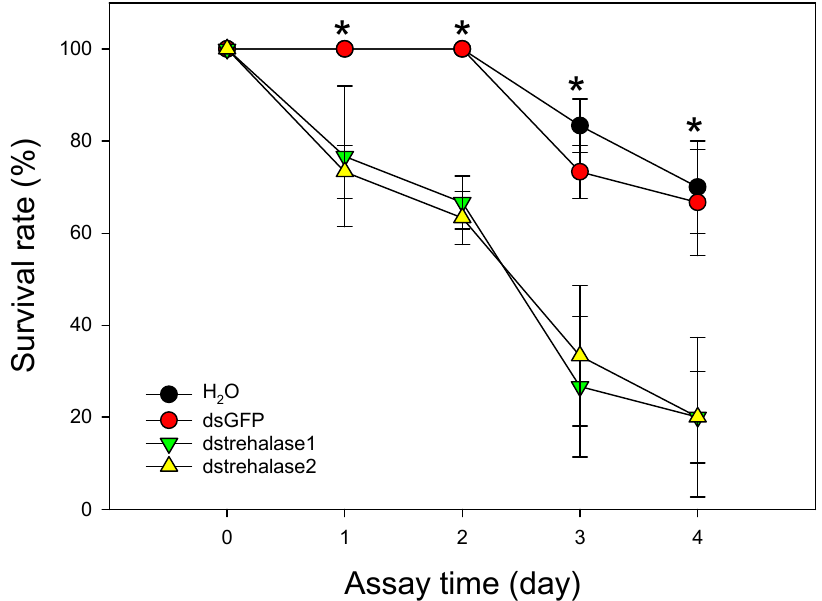
Figure 10. Effect of trehalase1-specific double-stranded RNA (dstrehalase1) and trehalase2-specific double-stranded RNA (dstrehalase2) treatment on D. citri 2nd instars mortality. D. citri 2nd instars were treated with dstrehalase1, dstrehalase2, green fluorescent protein-specific dsRNA (dsGFP), or water (H 2 O) and monitored for mortality. Values shown in the figure are means ± SE. * Indicates statistically significant differences ( p < 0.05; ANOVA, Tukey’s multiple comparisons test).